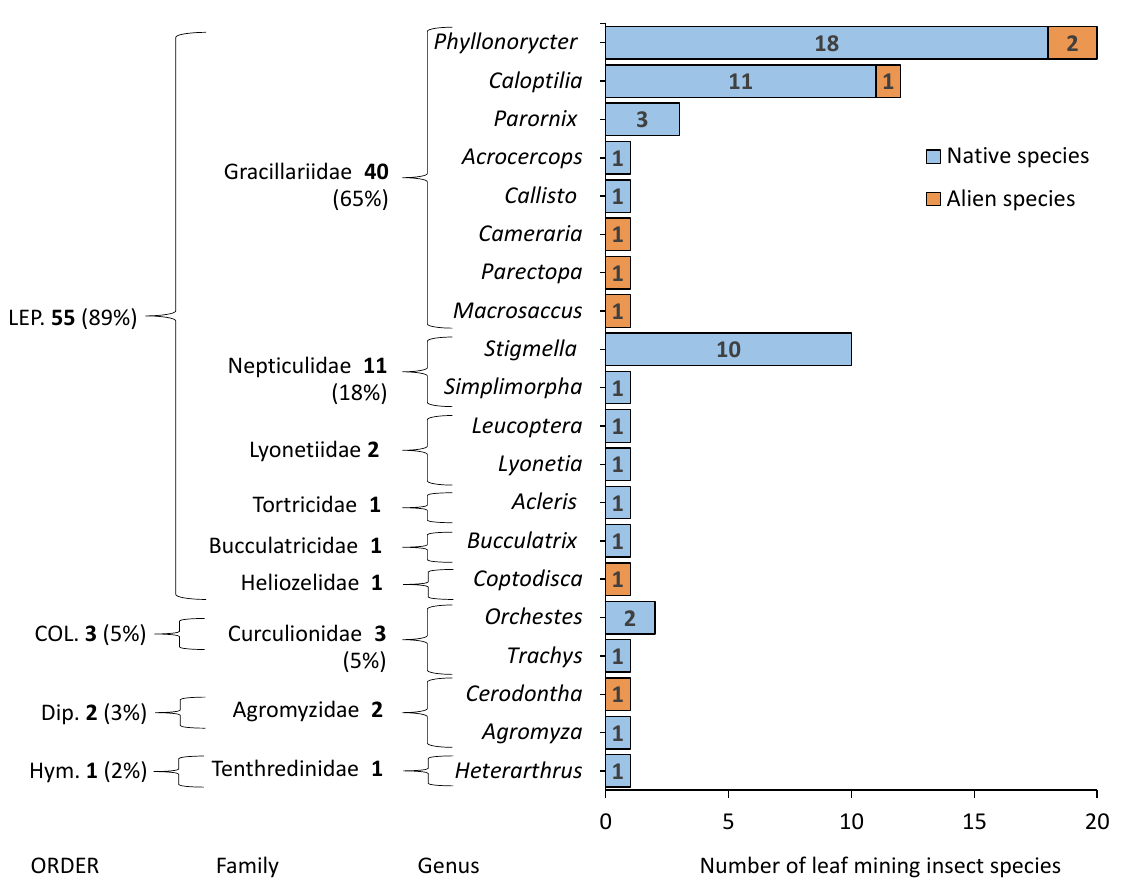
Figure 2. Number of leaf-mining insect species from various genera, families, and orders recorded in the Volčji Potok Arboretum (Slovenia) in the period 2022–2023. Orders: Lep.—Lepidoptera, Col.—Coleoptera, Hym.—Hymenoptera, Dip.—Diptera. The number of species in families and orders is given in bold in the figure.